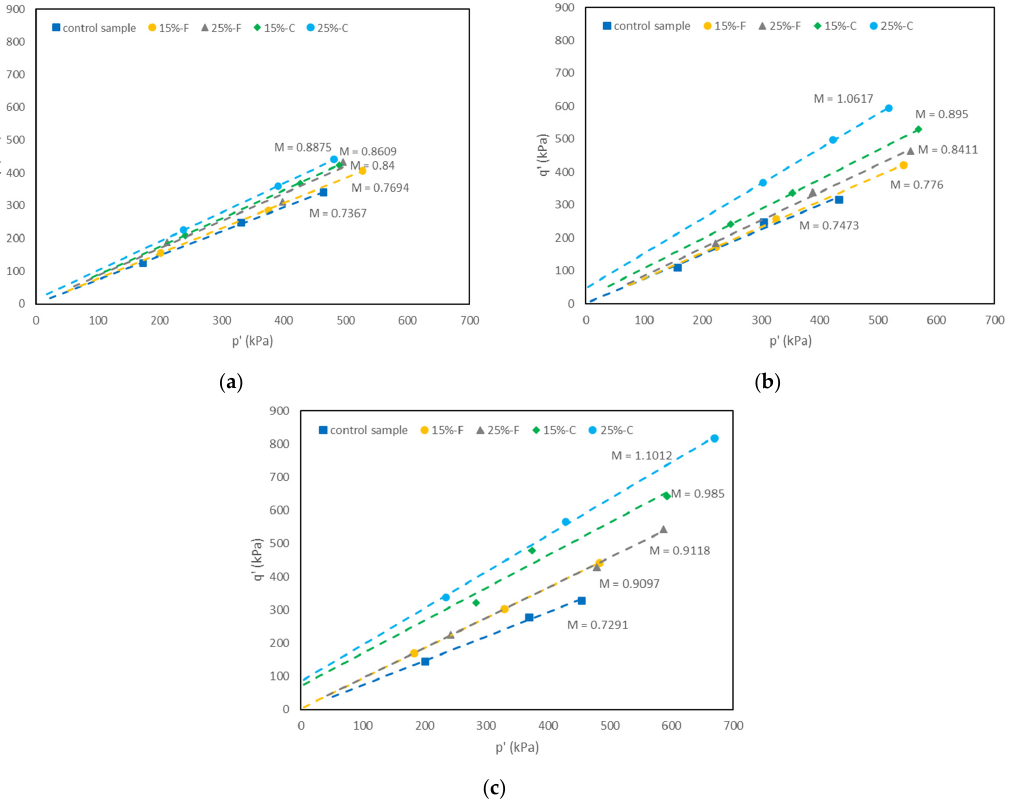
Figure 11. Critical state lines for the control sample and the soil samples stabilized with class C and